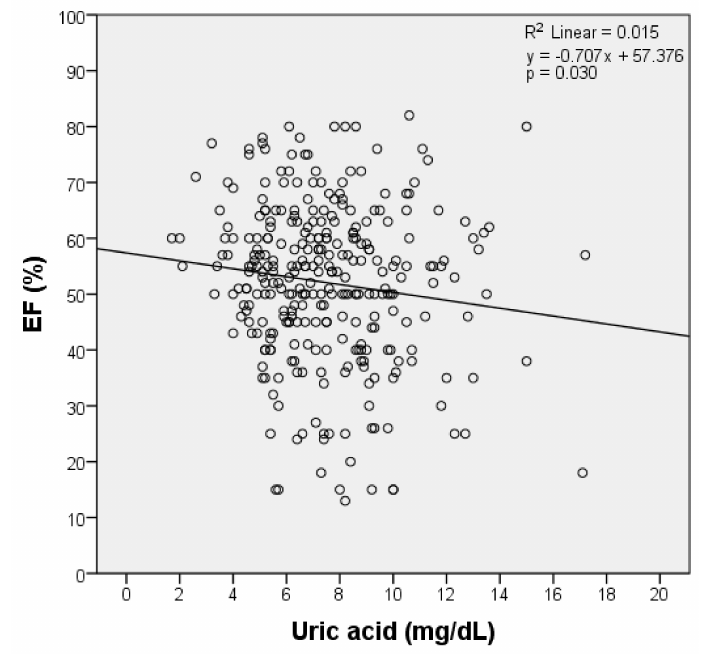
Figure 1. Single linear regression analysis among EF groups and serum uric acid. Scatter plot with the corresponding regression line and regression equation shows the correlation between FEVS and uric acid. Note: FEVS = left ventricular ejection fraction.